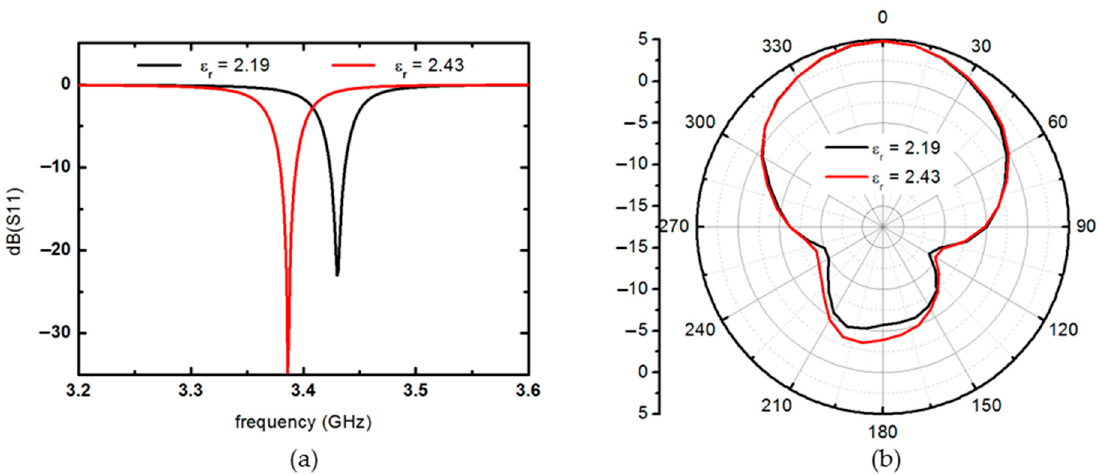
Figure 8. ( a ) dB(S11) examples and ( b ) E-plane radiation patterns of the patch antenna when dielectric constant changes from ε ∥ to ε ⊥ .